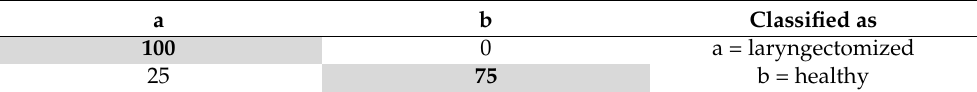
Table 7. Error matrix for the classification of the third phonetic segment. Used k-NN, cross-validation method (k = 10). General recognition 87.5%.